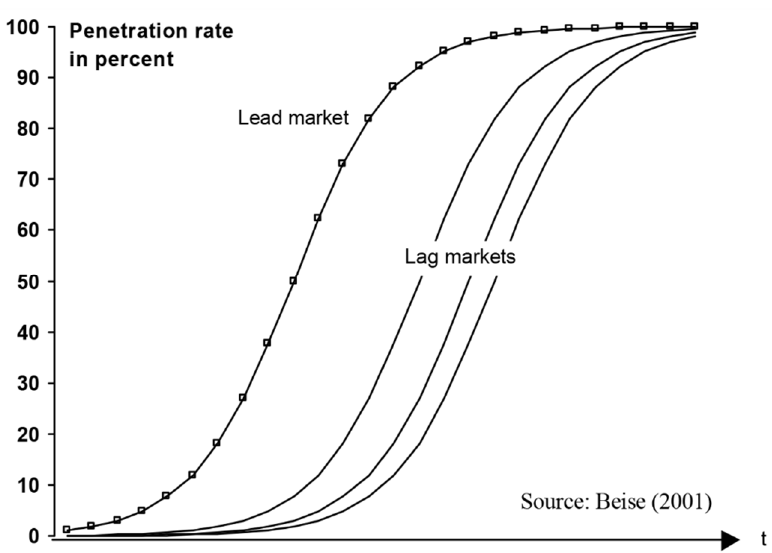
Figure 3. The international diffusion of an innovation design.